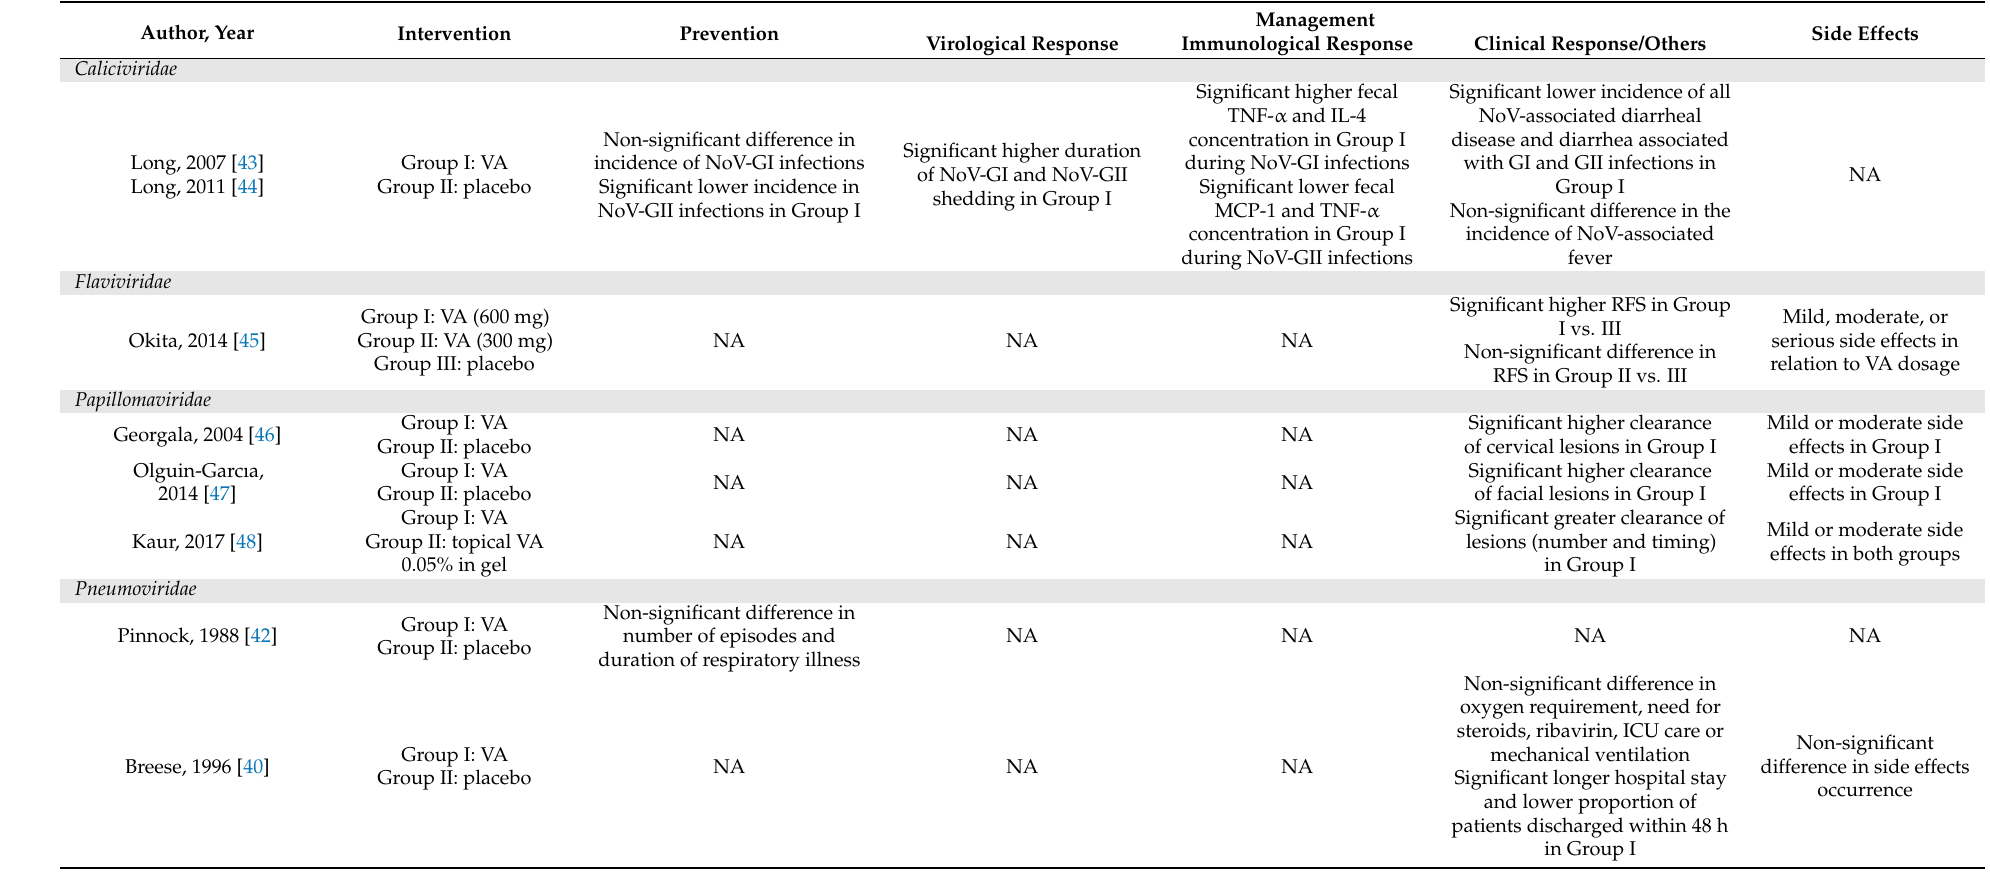
Table 3. Main effects of Vitamin A (VA) oral administration in the prevention and management of viral infections by virus